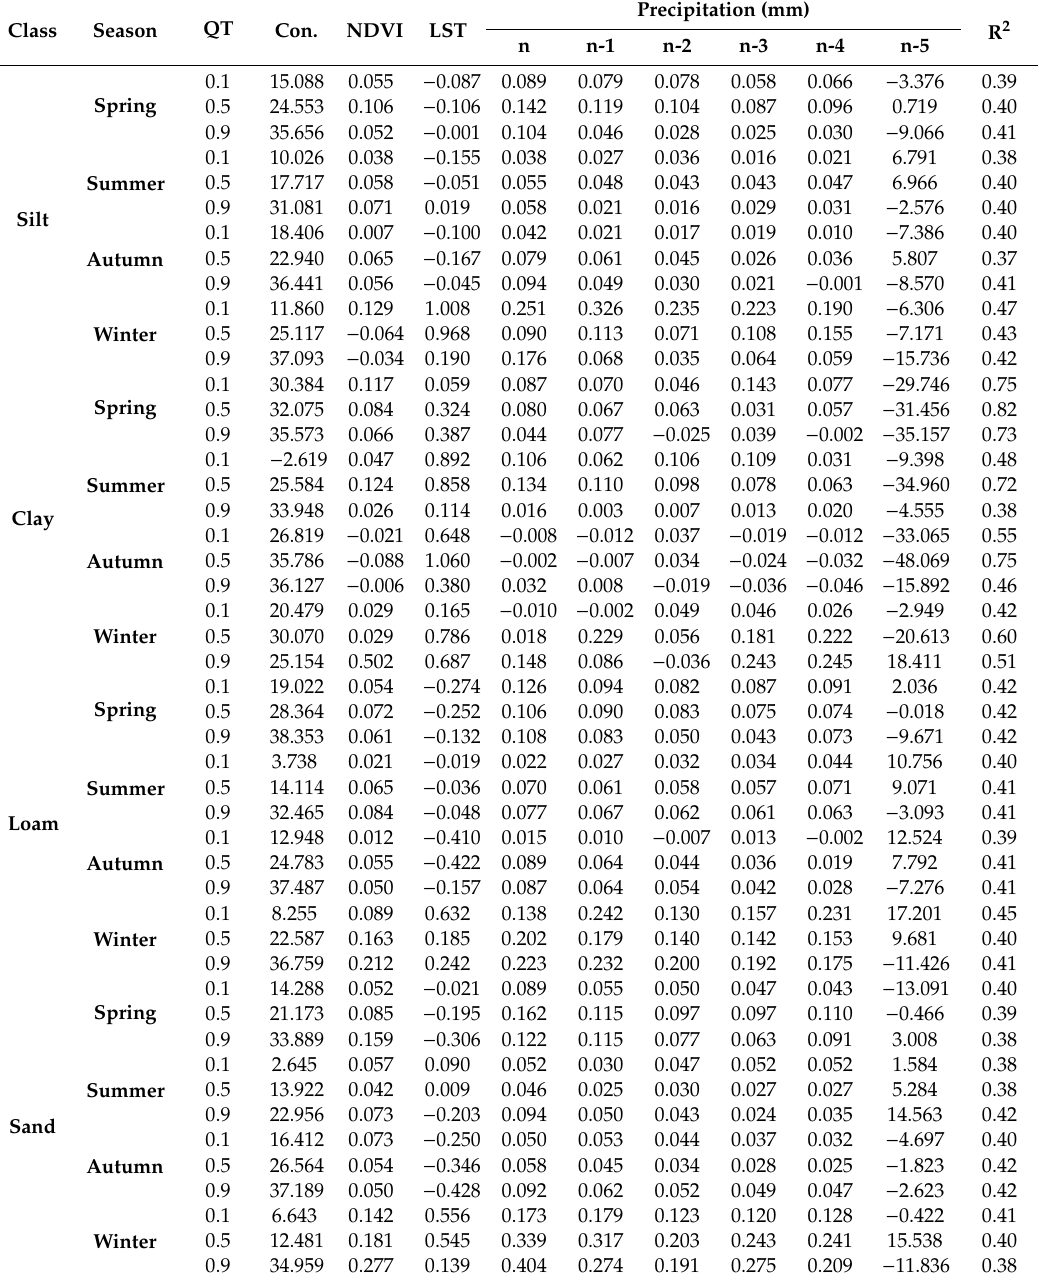
Table 3. Seasonal multiple quantile regression (MQR) regression coe ffi cients according to soil